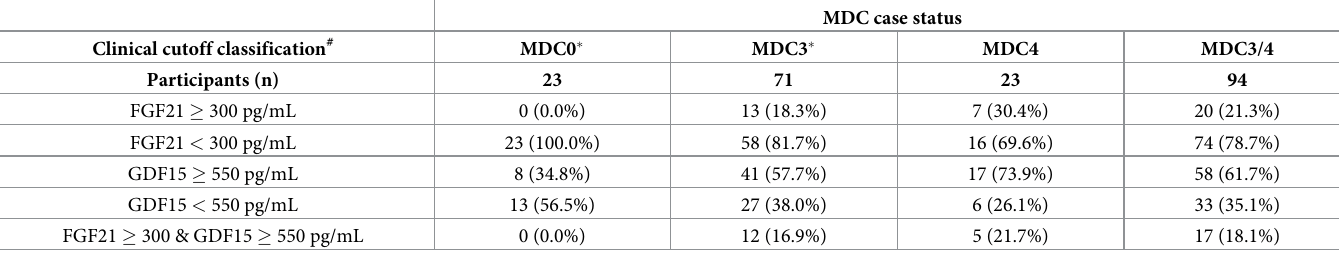
Table 2. Individual discrimination of published mitokine clinical cutoffs by case